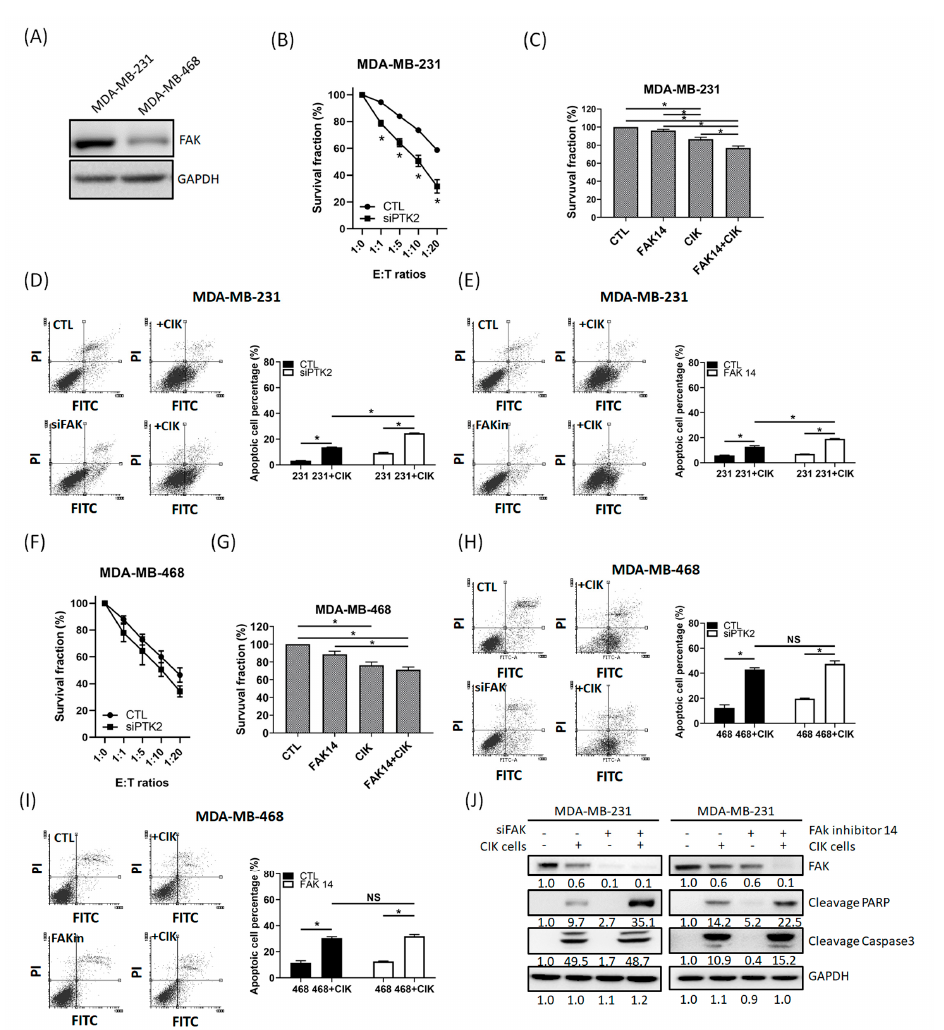
Figure 3. Focal adhesion kinase (FAK) inhibition in triple-negative breast cancer (TNBC)